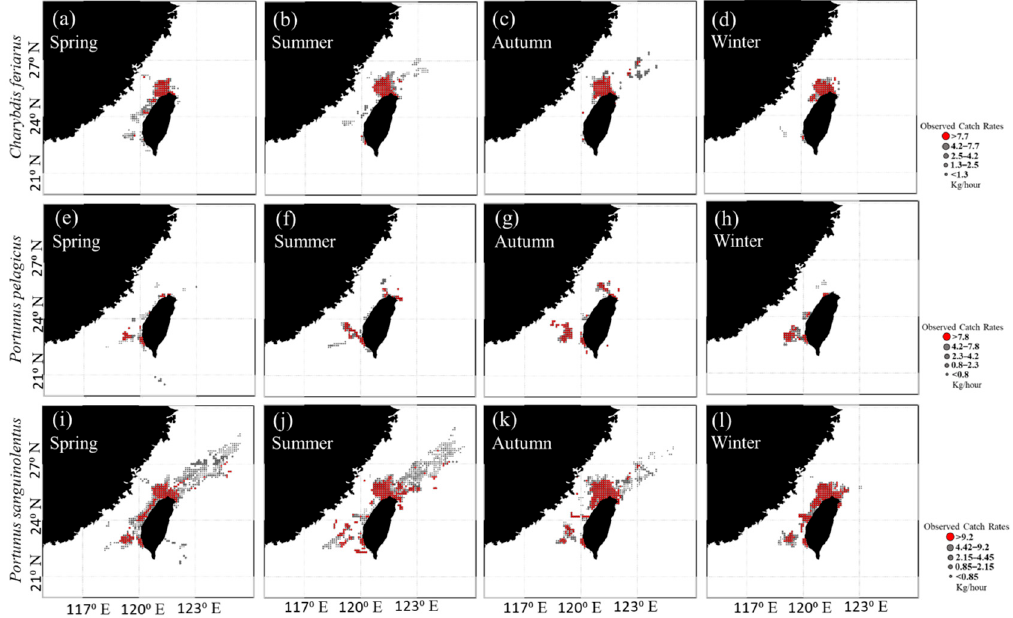
Figure 2. Seasonal mean observed catch rates of C. feriatus ( a)–(d ), P. pelagicus ( e)–(h ), and P. sanguinolentus ( i)–(l ). ( i – l